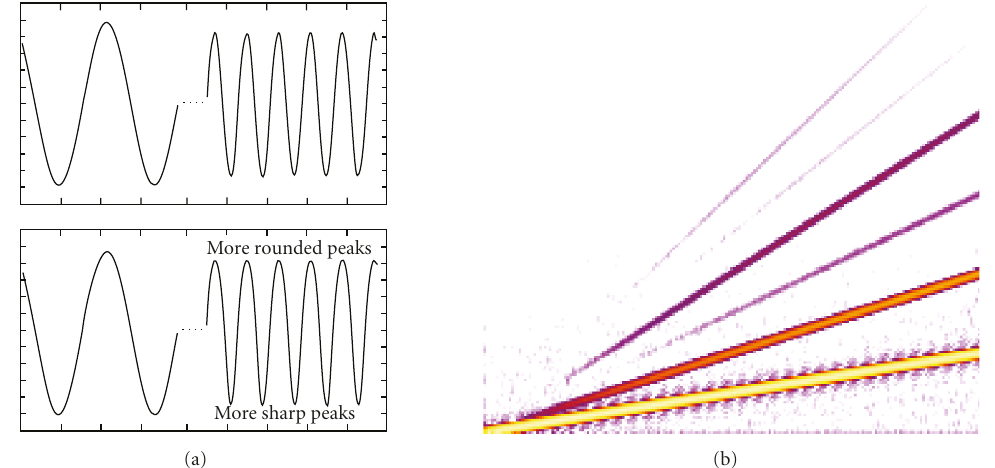
Figure 10: Top left: unaltered sine frequency sweep. Bottom left: altered sine sweep. The distortion introduced by incorrect exposure is noticeable at high frequency. Right: spectrogram of the beginning of the sweep. The even-order harmonics due to the desymmetrization appear first, then the odd-order harmonics caused by the change in shape.